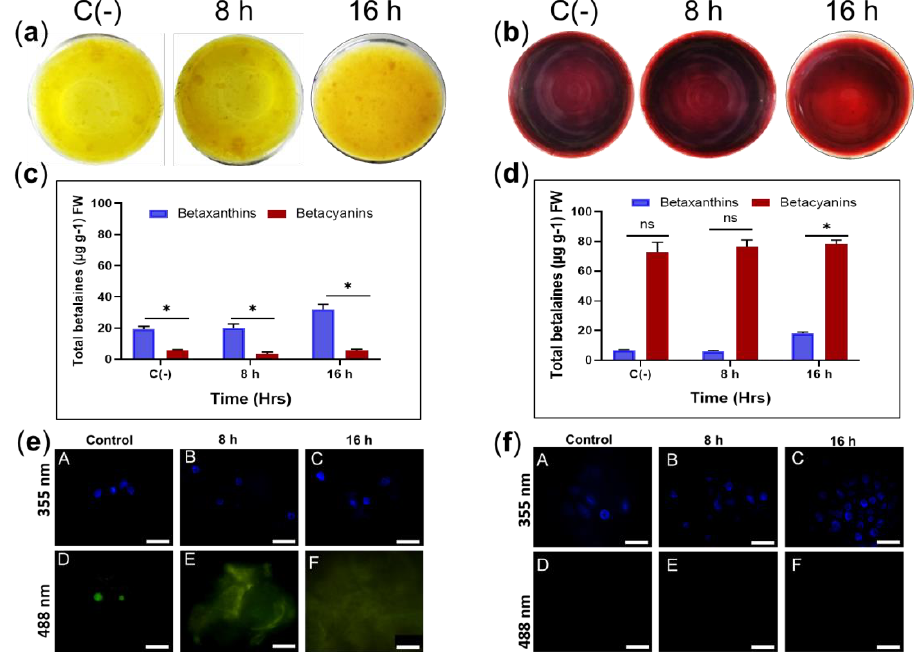
Figure 6. Effect of temperature on sqY1 and sqR1 cell lines. ( a ). Behaviors of sqY1 and ( b ) sqR1 cell lines under thermal stress at 45 °C for 8 and 16 h. ( c ) Quantification of total betalains in the sqY1 line and ( d ) in the sqR1 line. All experiments were obtained at a significance level whit three independents replicates. Bars indicate standard error. (*) Indicate statistical significance at p < 0.05. (ns) Indicate no statistical significance. Bar indicates standard error ( e : A–C). Localization of nuclei stained with DAPI at 388 nm and in sqY1 and ( f : A–C) in the sqR1 line. ( e : D, E, F) Autofluorescence at 488 nm in the sqY1 line. ( f : D–F) Absence of autofluorescence at 488 in the sqR1 line. Bar scale 10 μ m.